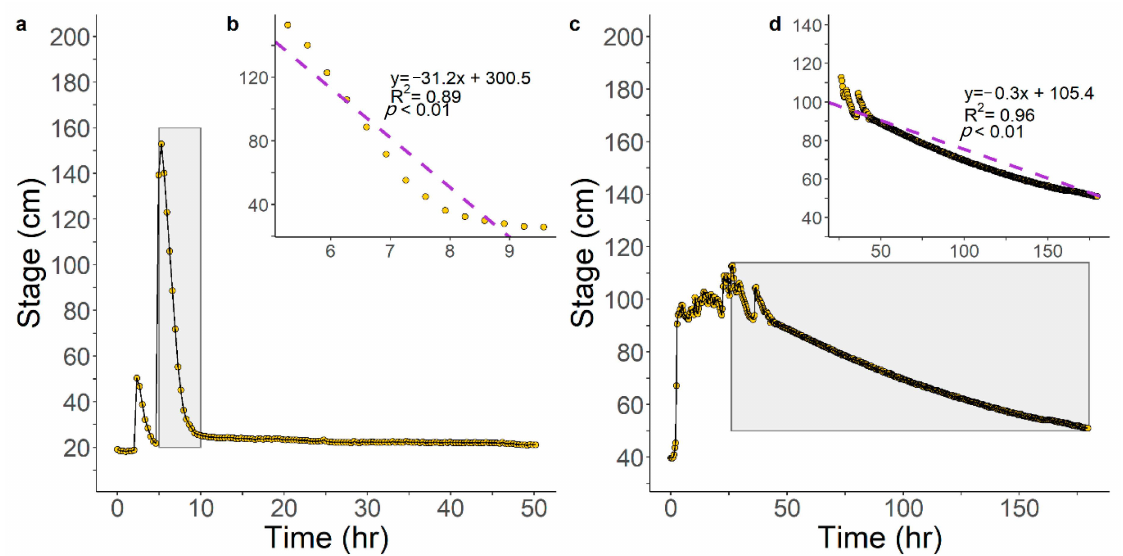
Figure 8. Outlet stage response to a 3.7 cm rain event in September of 2018 for the dry detention basin ( a , b ). Outlet stage response to a 4.3 cm rain event for the wetland in September of 2019 ( c , d ). The slope of the stage decline for the basin ( b ) was 2 orders of magnitude steeper than the wetland ( d ). Grey-shaded boxes denote range of inset graphs ( b , d ).